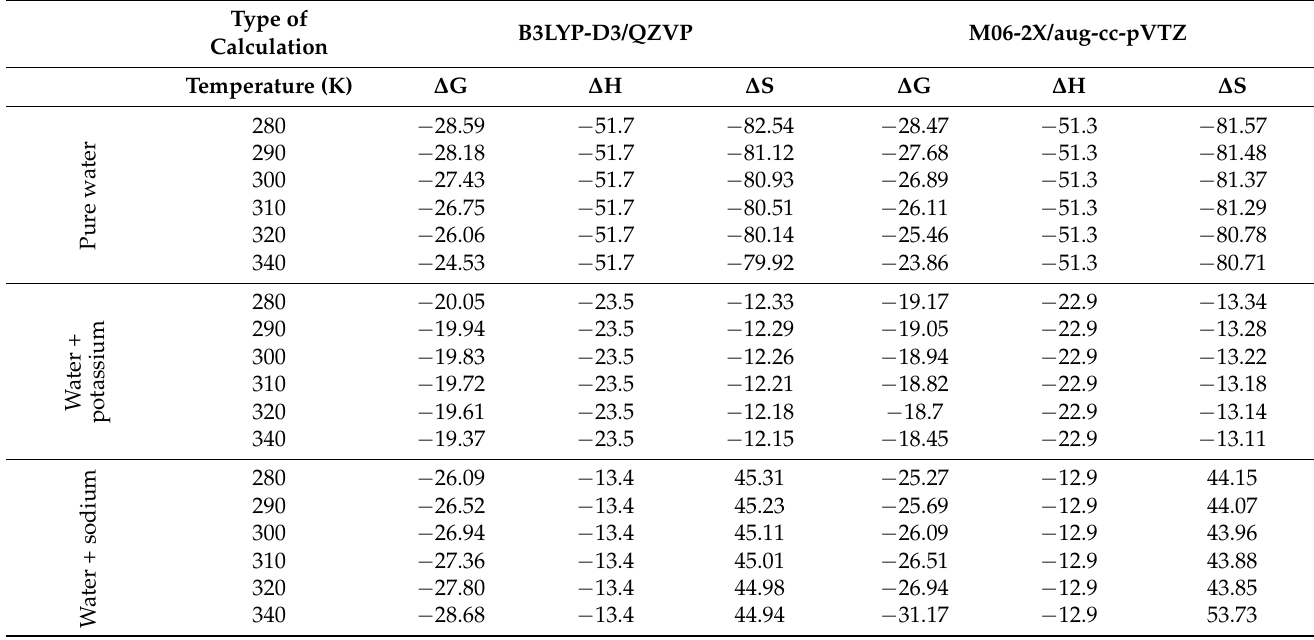
Table 2. Gibbs free energy, enthalpy (in kJ/mol), and entropy (J/K · mol) changes associated to the formation of (H 2 O) 3 clusters.